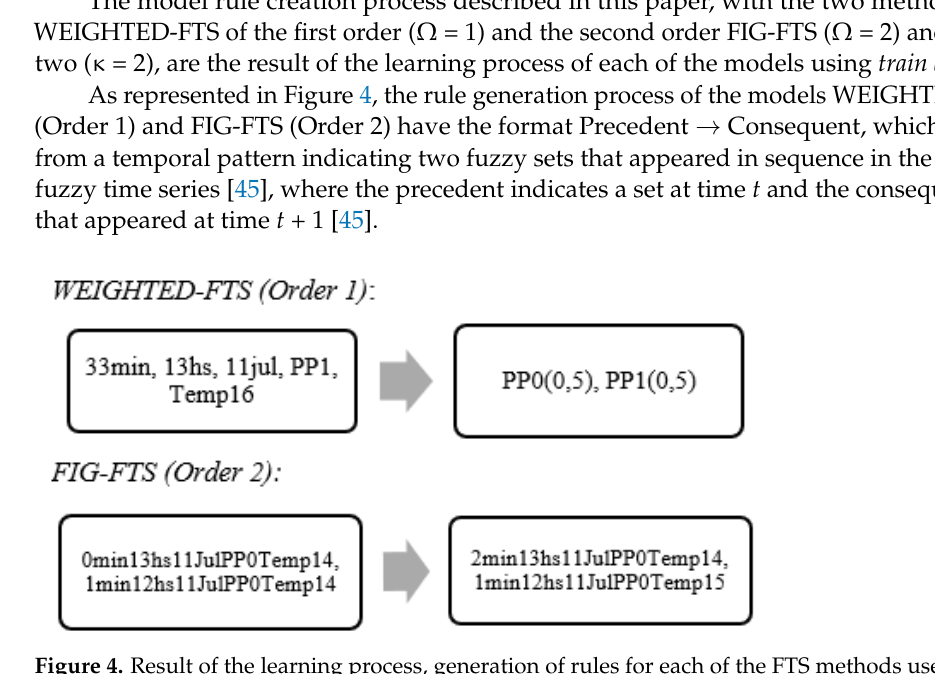
Figure 4. Result of the learning process, generation of rules for each of the FTS methods used.